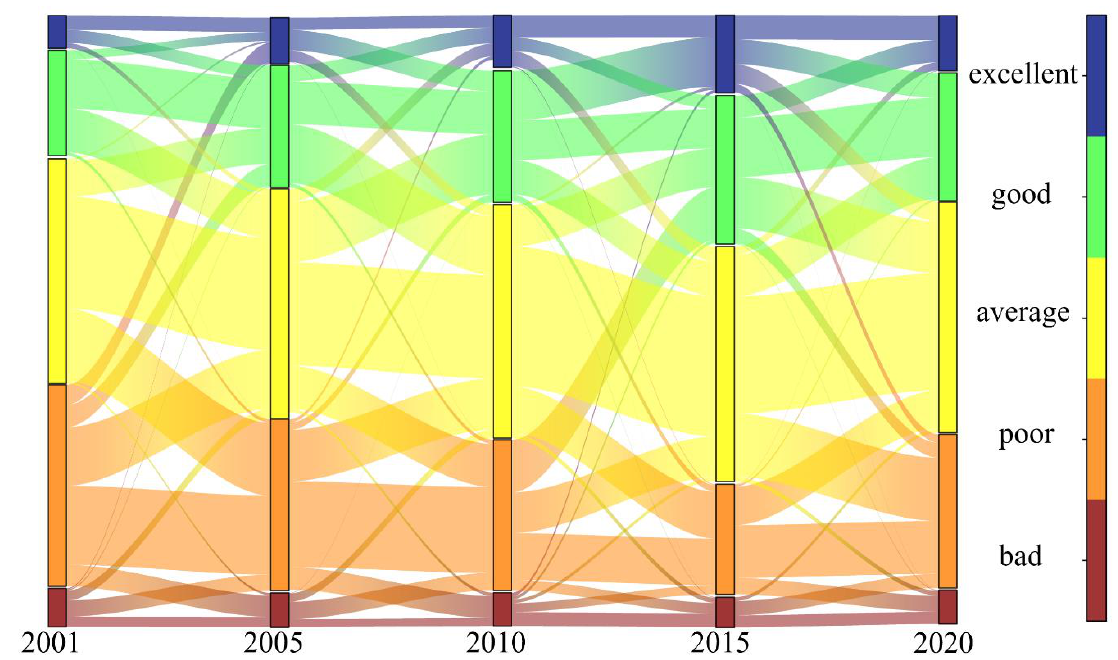
Figure 4. Sankey remote sensing ecological index transfer matrix.